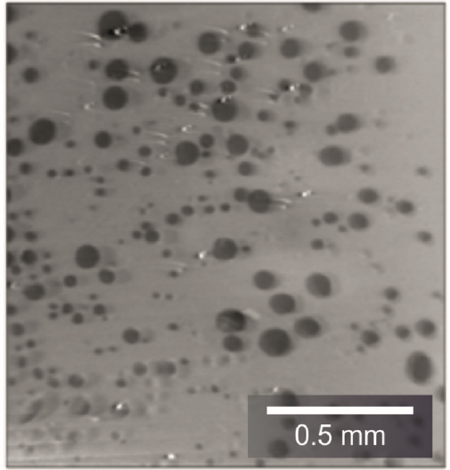
Figure 13. Sectional view through the bitumen emulsion with 10 wt% coarse barite sand.